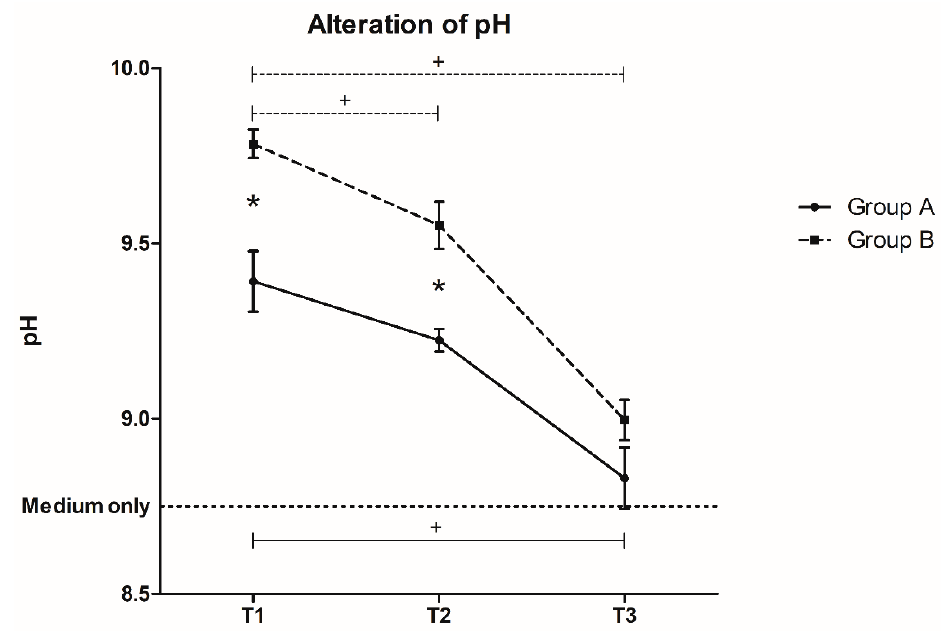
Figure 4. Variation of pH during immersion in DMEM. DMEM without contact to scaffolds was taken as a reference (“Medium only,” dashed line, pH = 8.75). Immersion duration is plotted on the x -axis according to the scan time points (T1–T3). Significant differences between group A-scaffolds and group B-scaffolds are marked with (*), significant differences in pH between two immersion time points in one scaffold group are indicated with a bracket in combination with a (+).